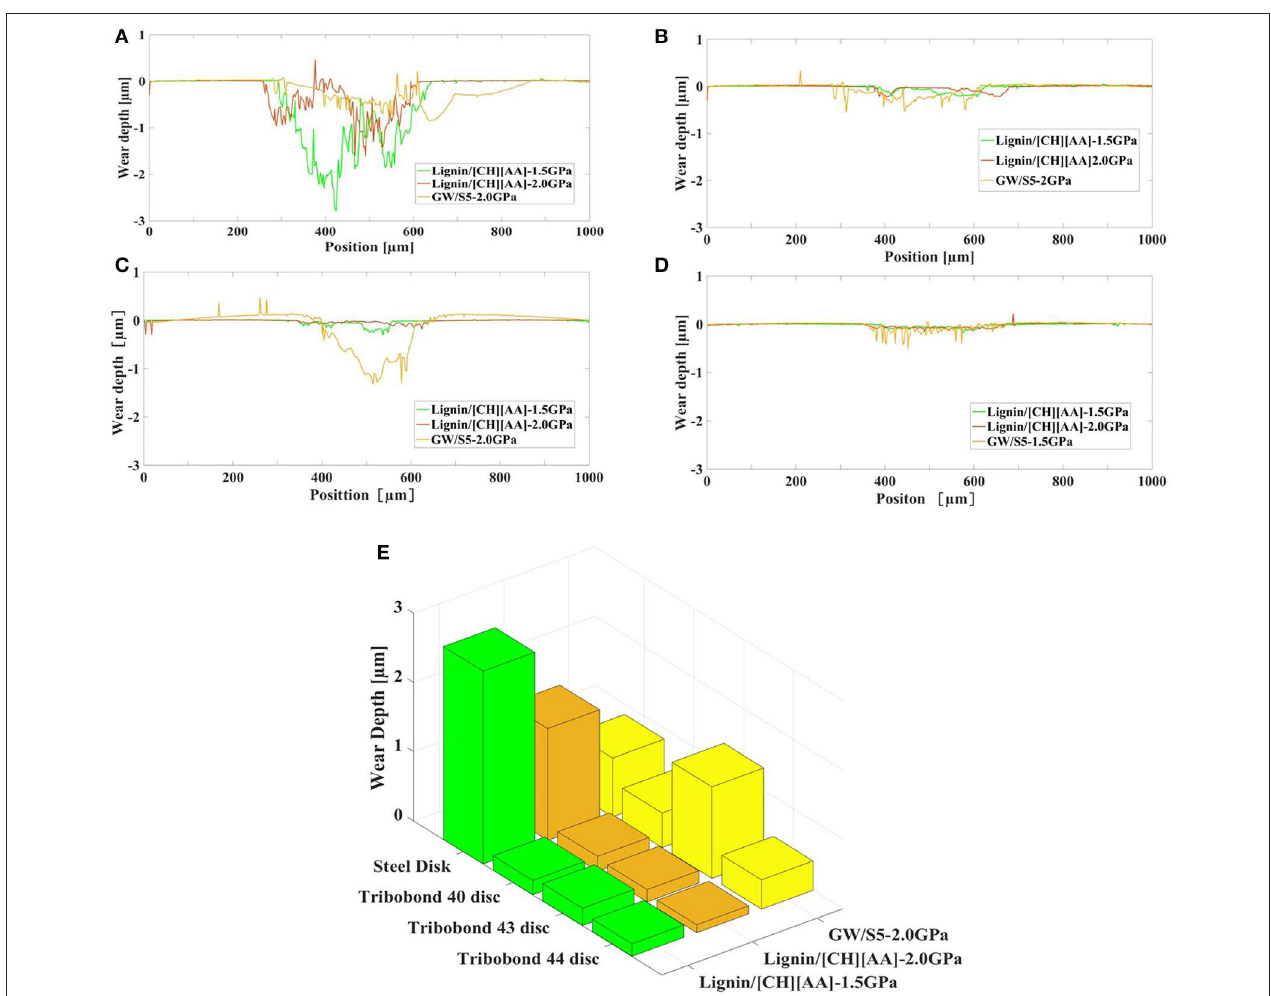
FIGURE 6 | Cross-sectional profile of typical worn surface of steel ball: (A) steel disc, (B) Tribobond 40 disc, (C) Tribobond 43 disc, (D) Tribobond 44 disc; (E) Comparison of wear